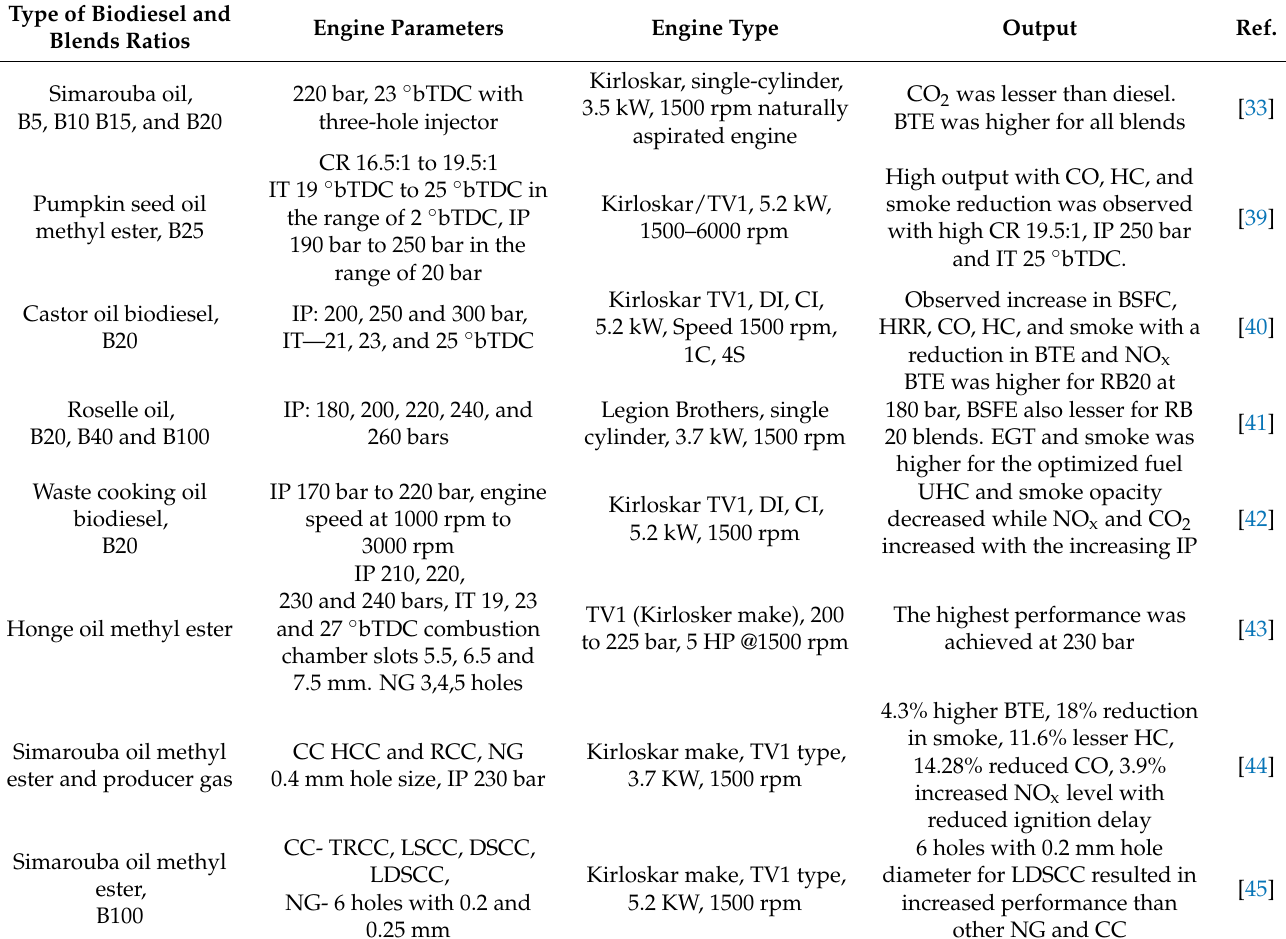
Table 1. Influence of injection pressure and nozzle geometry on engine performance using different biodiesels. Type of Biodiesel and Engine Parameters Engine Blends Ratios